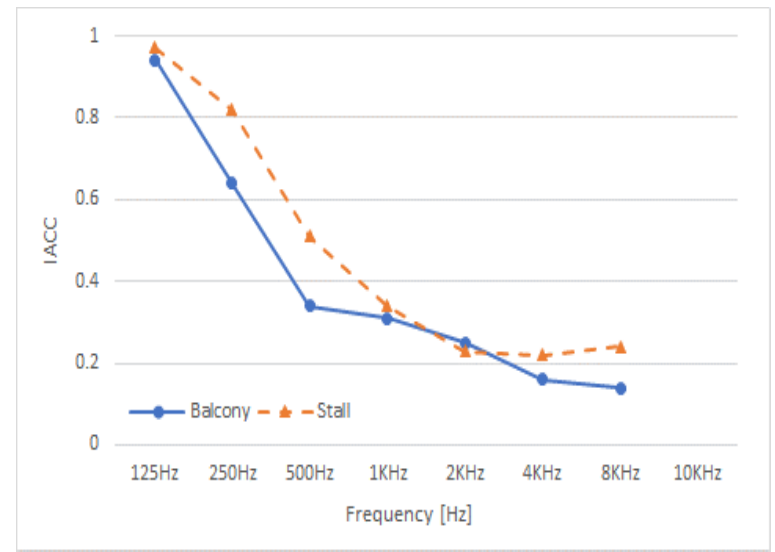
Figure 13. Measurements results of the Interaural Cross-Correlation